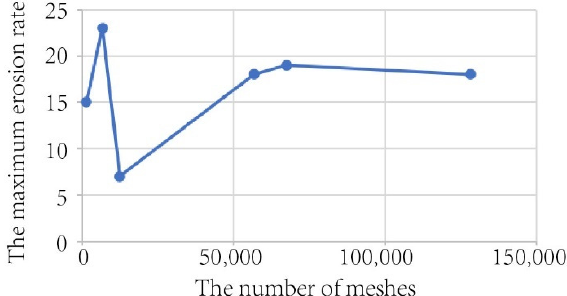
Figure 4. The maximum erosion rate is related to the number of meshes.